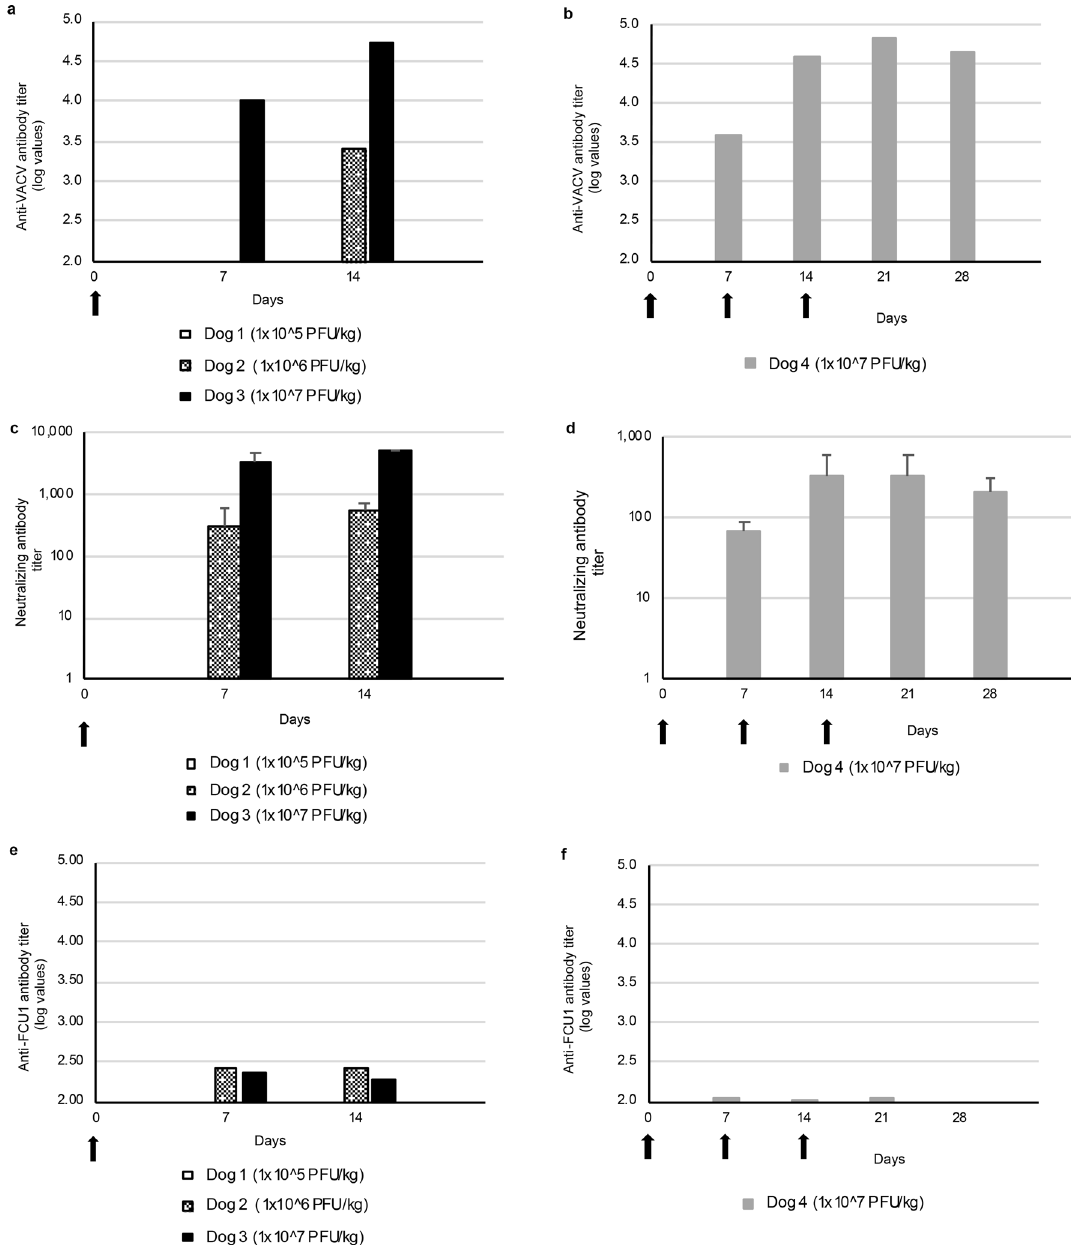
Figure 5. Immune responses of dogs after single or multiple intravenous injection of TG6002. ( a) Anti-VACV antibody titers after single injection of TG6002. ( b) Anti-VACV antibody titers after three injections of TG6002. ( c) Neutralizing antibody titers after single injection of TG6002. ( d) Neutralizing antibody titers after three injections of TG6002. ( e) Anti-FCU1 antibody titers after single injection of TG6002. ( f) Anti-FCU1 antibody titers after three injections of TG6002. Arrows indicate TG6002 administrations. For neutralizing antibody titers, samples were measured in triplicate and data are shown as mean ±